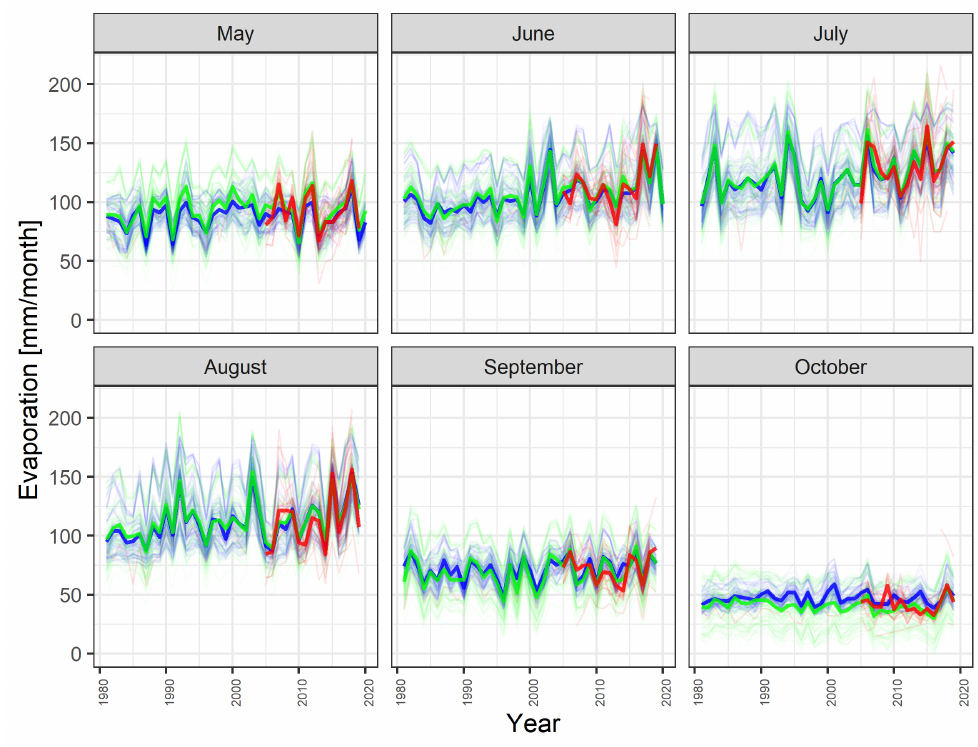
Figure 5. Monthly evaporation for the water reservoirs throughout 1981–2019 (green lines represent linear regression, blue lines represent random forest regression and red lines observed data) and from evaporation stations throughout 2005–2019. Bold lines represent means for water reservoirs and evaporation’s